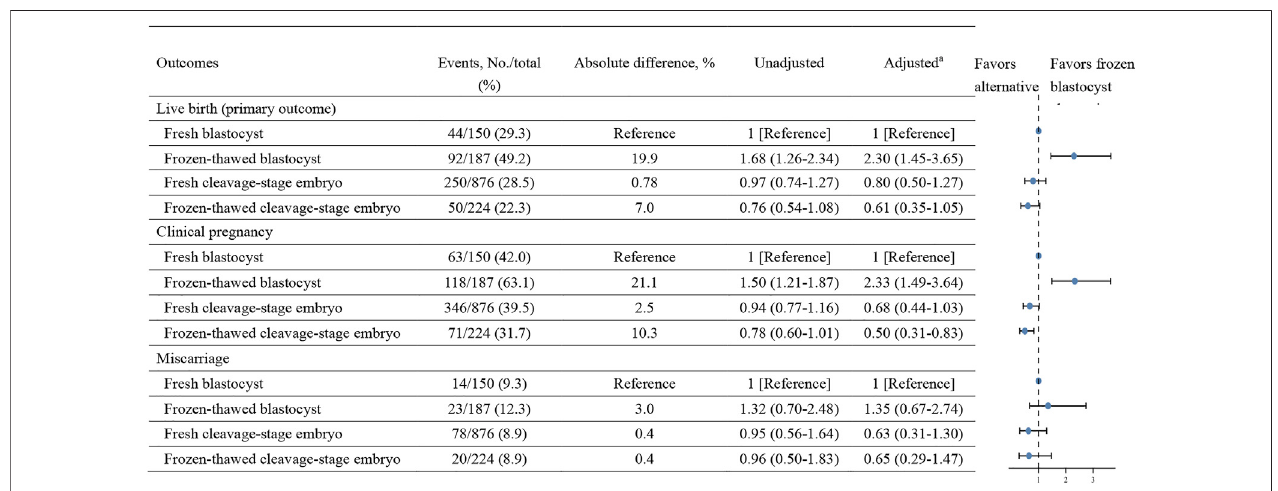
FIGURE 2 | Liver birth, clinical pregnancy, and miscarriage rates in fresh and frozen-thawed embryo transfers with cleavage-stage embryo and blastocyst.